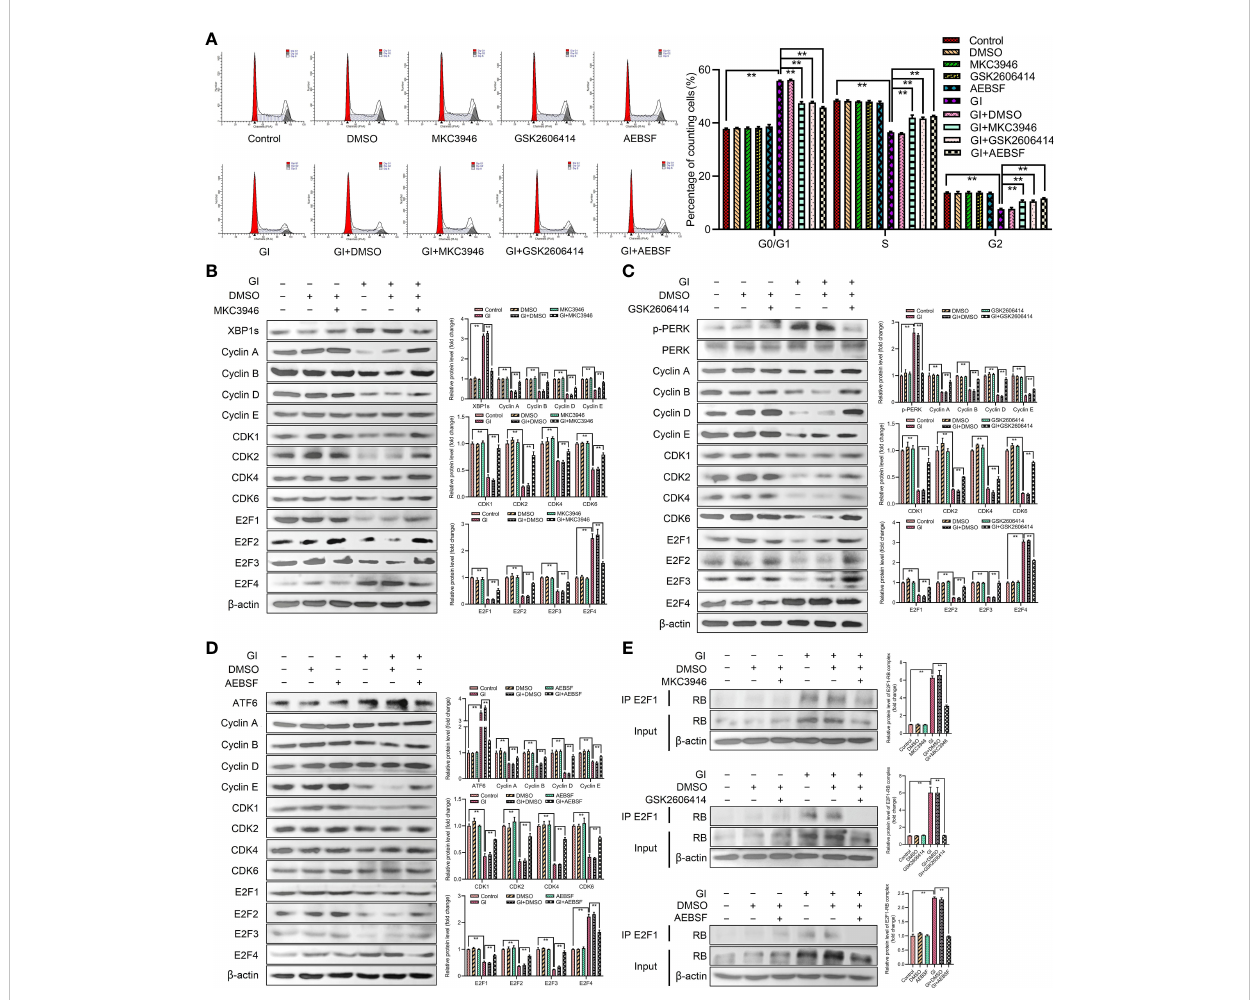
FIGURE 4 Giardia arrested cell cycle by activating three UPR signaling pathways. (A) PI staining followed by fl ow cytometry was used to detect cell cycle distribution in Caco-2 cells treated with or without inhibitors accompanied by Giardia exposure for 6 h; IRE1 inhibitor (MKC3946), PERK inhibitor (GSK2606414) and ATF6 inhibitor (AEBSF). G0/G1, S, and G2 indicate the different phases of the cell cycle. Under treatment of the combination of Giardia with (B) inhibitor MKC3946, (C) GSK2606414 or (D) AEBSF in Caco-2 cells, the expressions of cyclins, CDKs and E2Fs were detected by western blotting. (E) Co-IP experiments were performed to detect E2F1-RB complex formation in Caco-2 cells treated with or without inhibitors accompanied by Giardia exposure for 6 h; IRE1 inhibitor (MKC3946), PERK inhibitor (GSK2606414) and ATF6 inhibitor (AEBSF). Gl, Giardia .